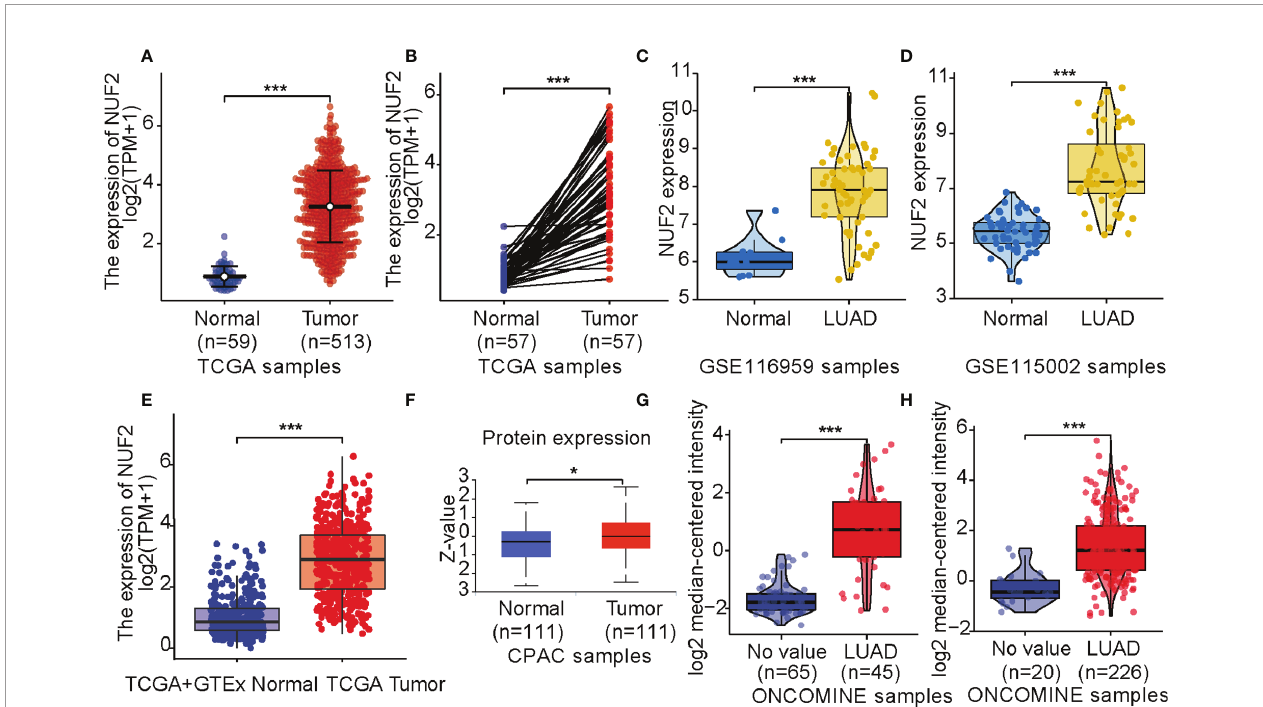
FIGURE 1 | NUF2 expression levels. (A) Expression levels of NUF2 in lung adenocarcinoma (LUAD) and normal tissue from The Cancer Gene Atlas (TCGA). (B) the expression of NUF2 in LUAD and its paired adjacent tissues. (C) mRNA expression of NUF2 in LUAD was obtained from GSE116959. (D) mRNA expression of NUF2 in LUAD was obtained from GSE115002. (E) Expression levels of NUF2 in tumor and normal tissues in TCGA and Genotype-Tissue Expression data. (F) The protein expression of NUF2 in LUAD was obtained from the CPTAC dataset. (G) NUF2 expression in tumor and normal tissues in LUAD from ONCOMINE database (Hou Lung). (H) NUF2 expression in tumor and normal tissues in LUAD from ONCOMINE database (Okayama Lung). ***p < 0.001,*p <